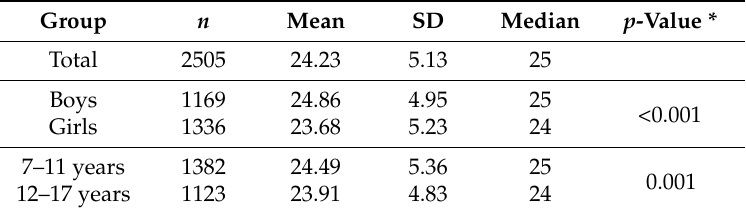
Table 4. Descriptive characteristics of HRQoL summed scores by groups of